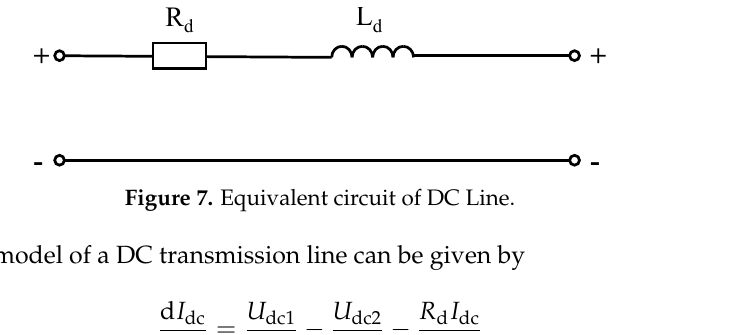
Figure 7. Equivalent circuit of DC